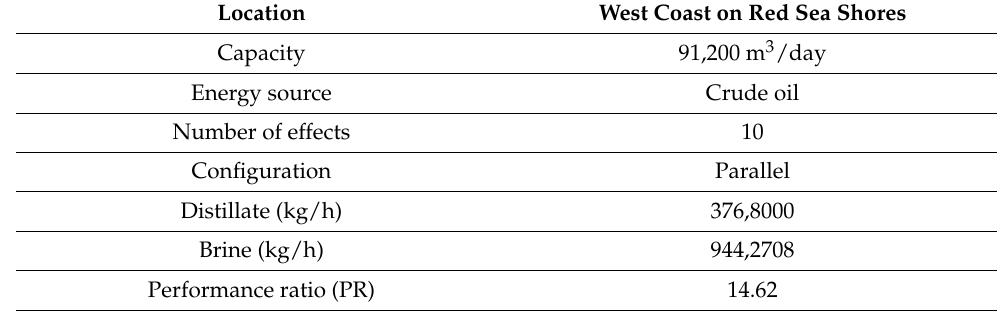
Figure 2. Schematic diagram of the existing MED-TVC. Table 1. Existing MED-TVC Desalination Plant’s Specific Information.